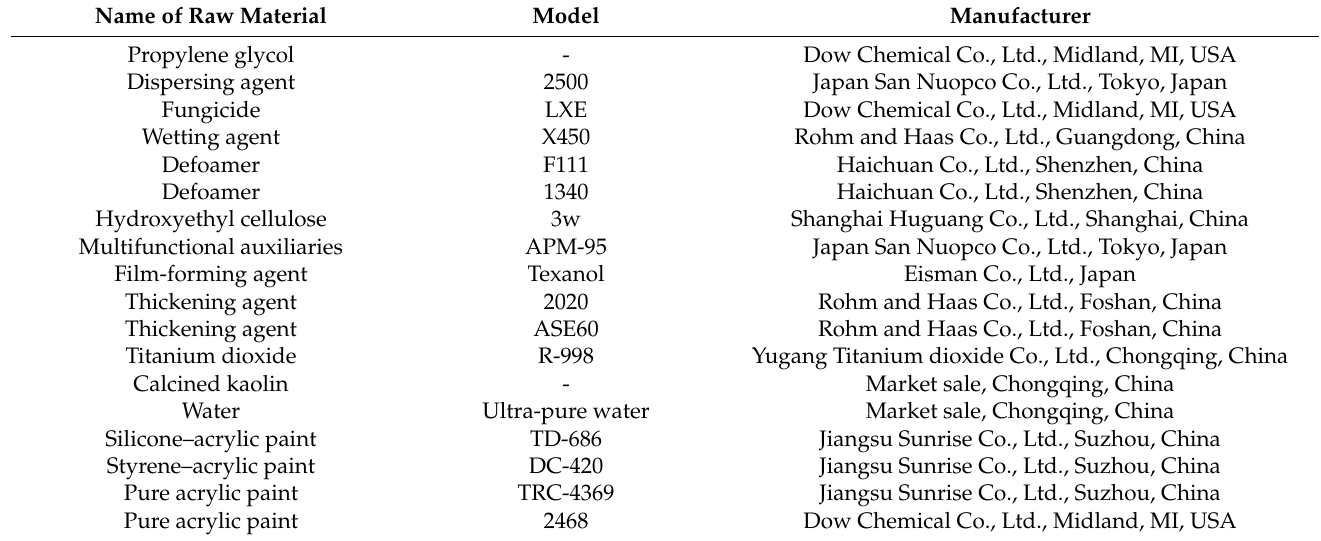
Table 1. Sources of raw materials of the experimental paints.